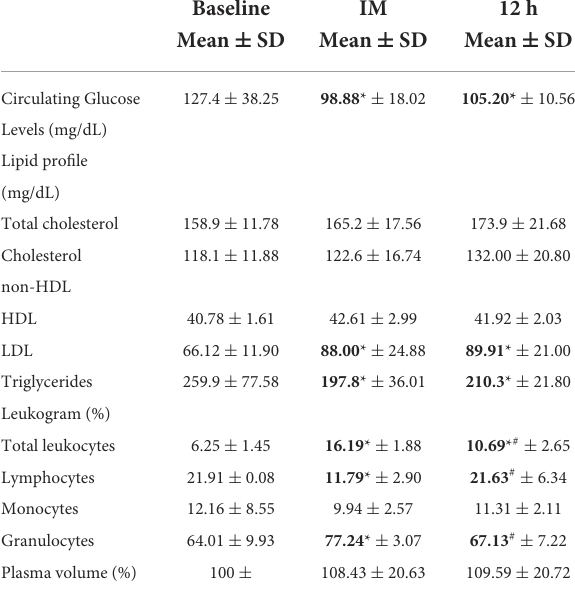
TABLE 2 Values [mean and standard deviation (SD) of circulating glucose levels, lipid profile (total cholesterol, cholesterol non-HDL, HDL, LDL, and triglycerides, in mg/dL), leukogram (total leukocytes, lymphocytes, monocytes, and granulocytes, in %), and plasma volume (in %) of volunteers in three different time-points: baseline, IM and 12h post-extreme ultra-triathlon